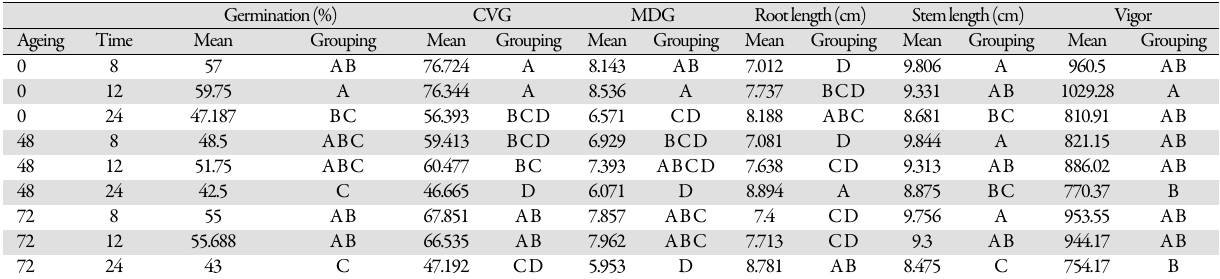
Table 4. Mean comparison of ageing and priming durations on germination properties of Silybum marianum